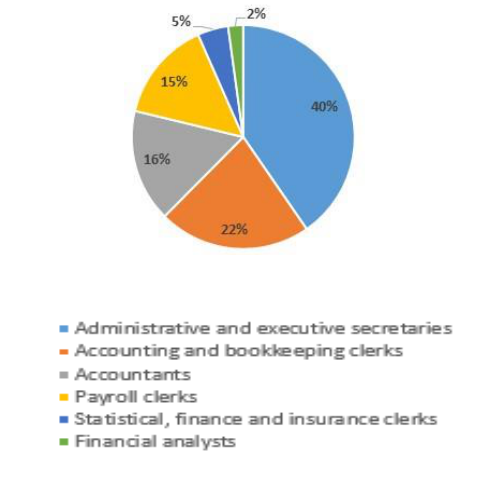
Figure 3: Occupation Profiles of Vacancies in area ADMINISTRATION AND